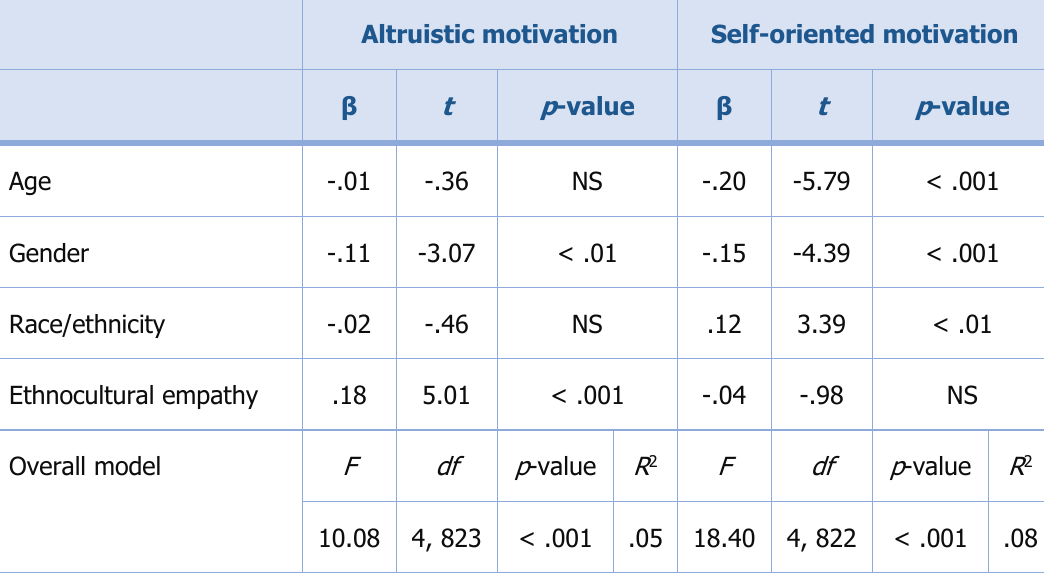
Table 2. Multiple Regression